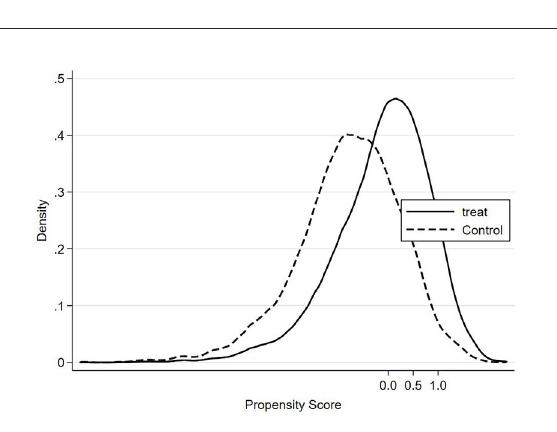
FIGURE2 Density distribution of the propensity score (Before matching).